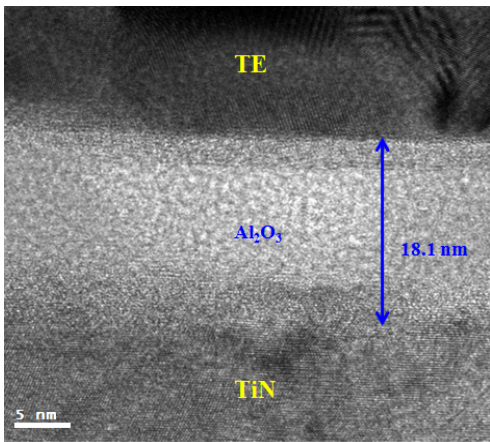
Figure 1. HRTEM (high-resolution transmission electron microscopy) image of the TE/Al 2 O 3 /BE structure.